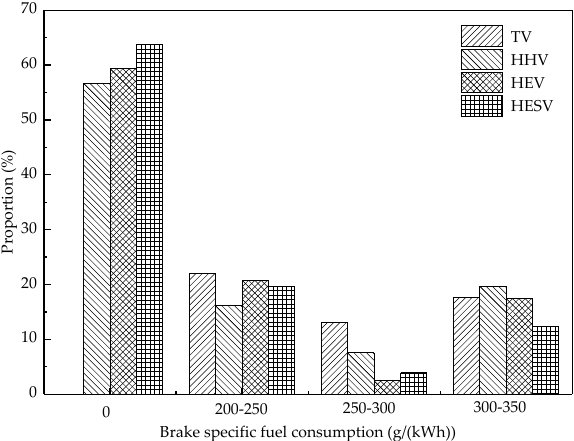
Figure 14. Distribution of engine working points.